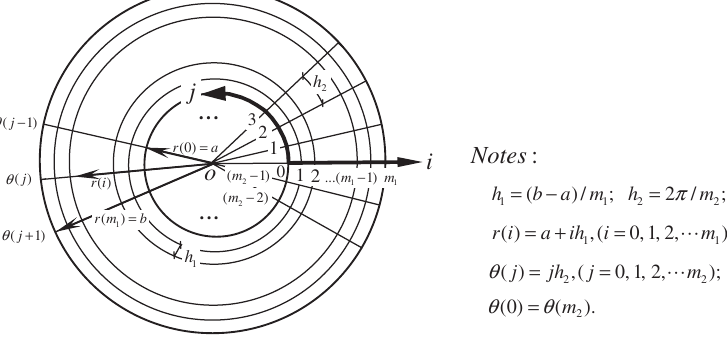
Figure 2 Schematic of the grids of the FGM hollow